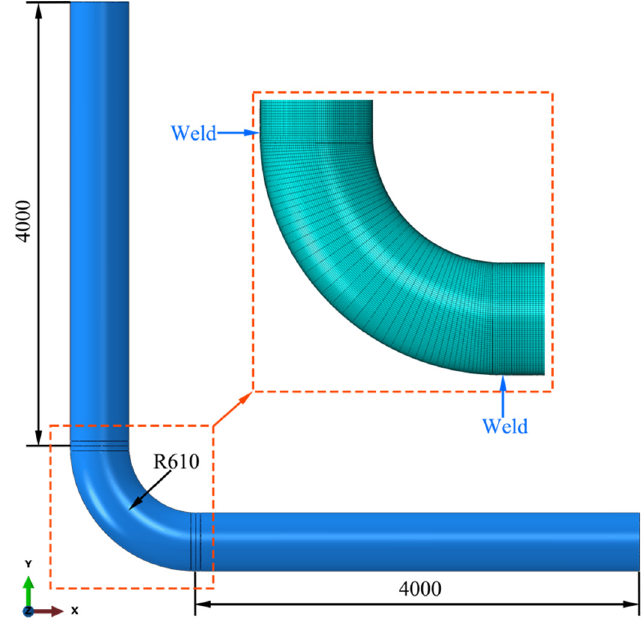
Figure 2. Simulation model and FE mesh (unit: mm).